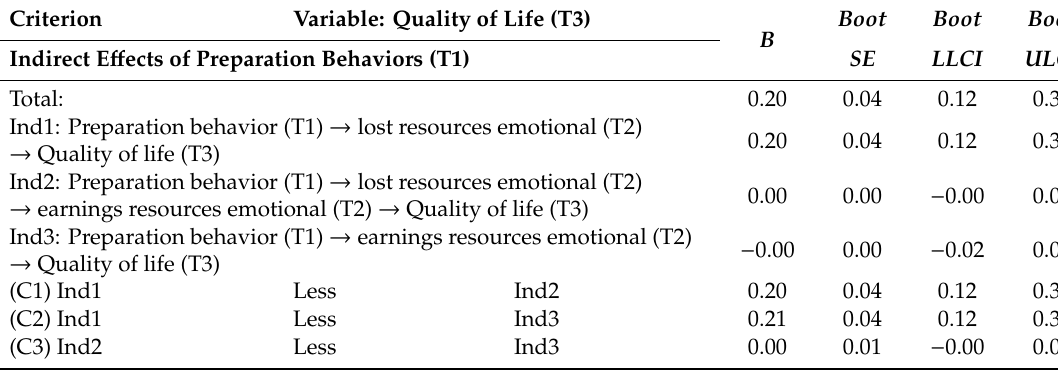
Table 7. Comparison of the indirect effects of preparation behaviors (T1) through losses (T2) and gains of emotional resources (T2) in the prediction of quality of life (T3).